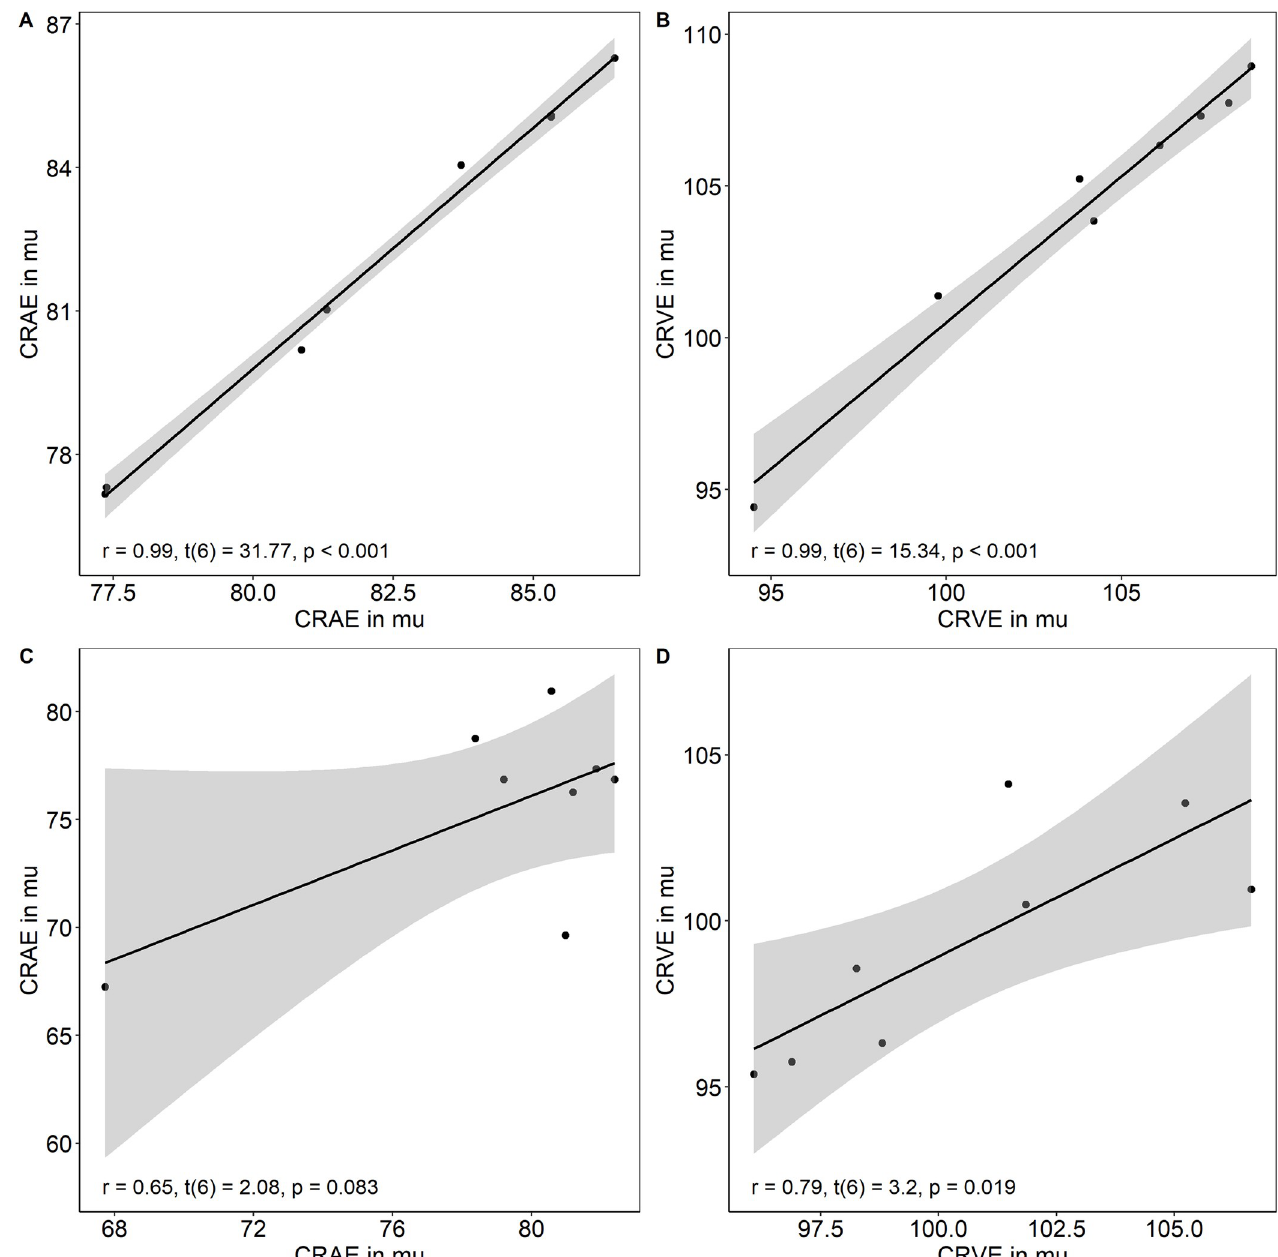
Fig 3. Interobserver variability. Interobserver variability of central retinal arteriolar (CRAE) and venular diameter equivalents (CRVE) were analysed. Three images from eight mice with (A and B) and three images from the same eight mice without fluorescein (C and D) were averaged and analysed by investigator one and two separately to investigate interobserver variability. Two-tailed Pearson correlations were computed in fluorescein and none-fluorescein images separately to analyse the interobserver variability between investigator one and two for CRAE and CRVE